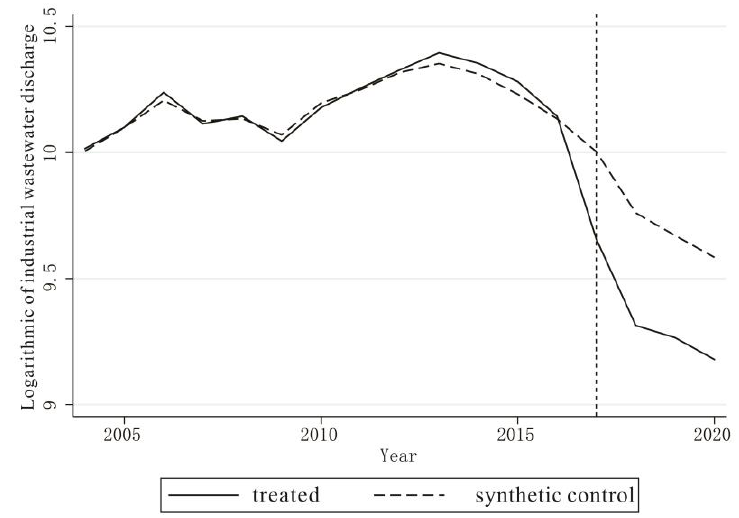
Figure 3. Industrial wastewater discharge in real and synthetic black land areas.